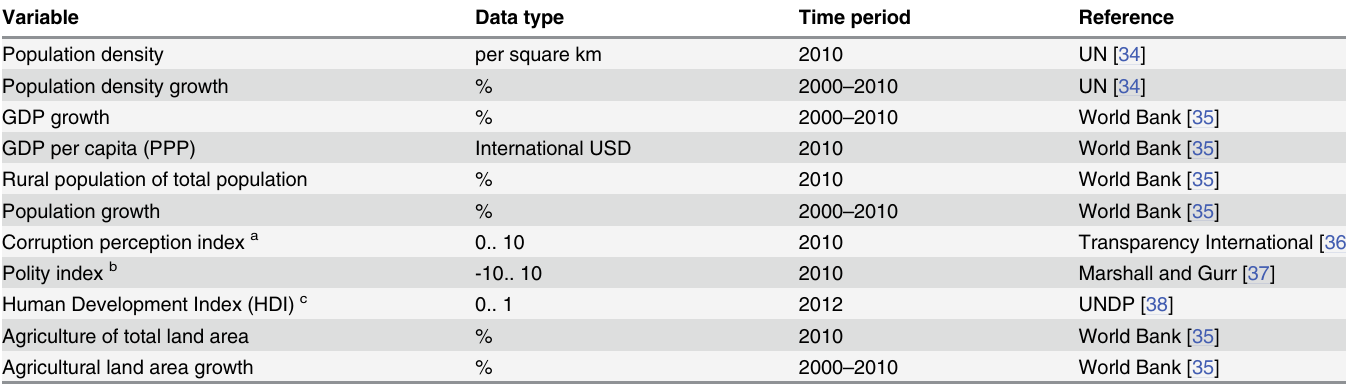
Table 3. The socio-economic indicators used in the regression analysis. The indicators were used as independent variables in the assessment of the forest loss drivers with Weighted Least-Squares (WLS) regression analysis.